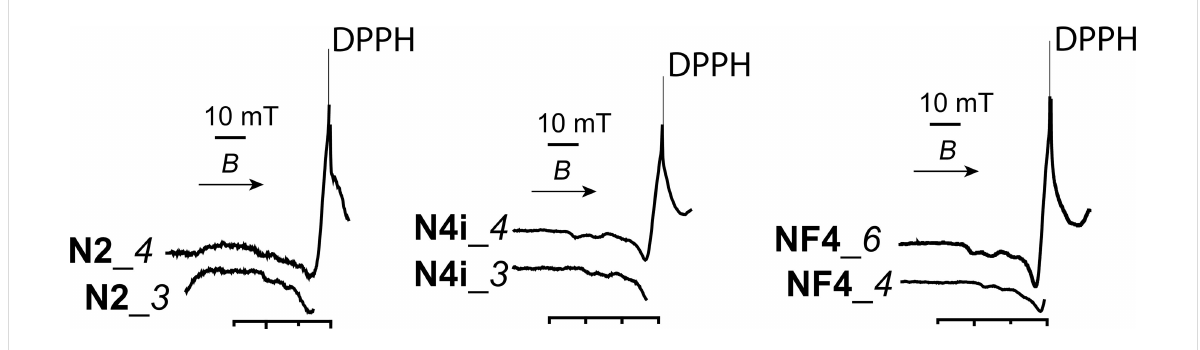
Figure 8: ESDR spectra for samples with different contents of Cu 2+ in the surface layer.